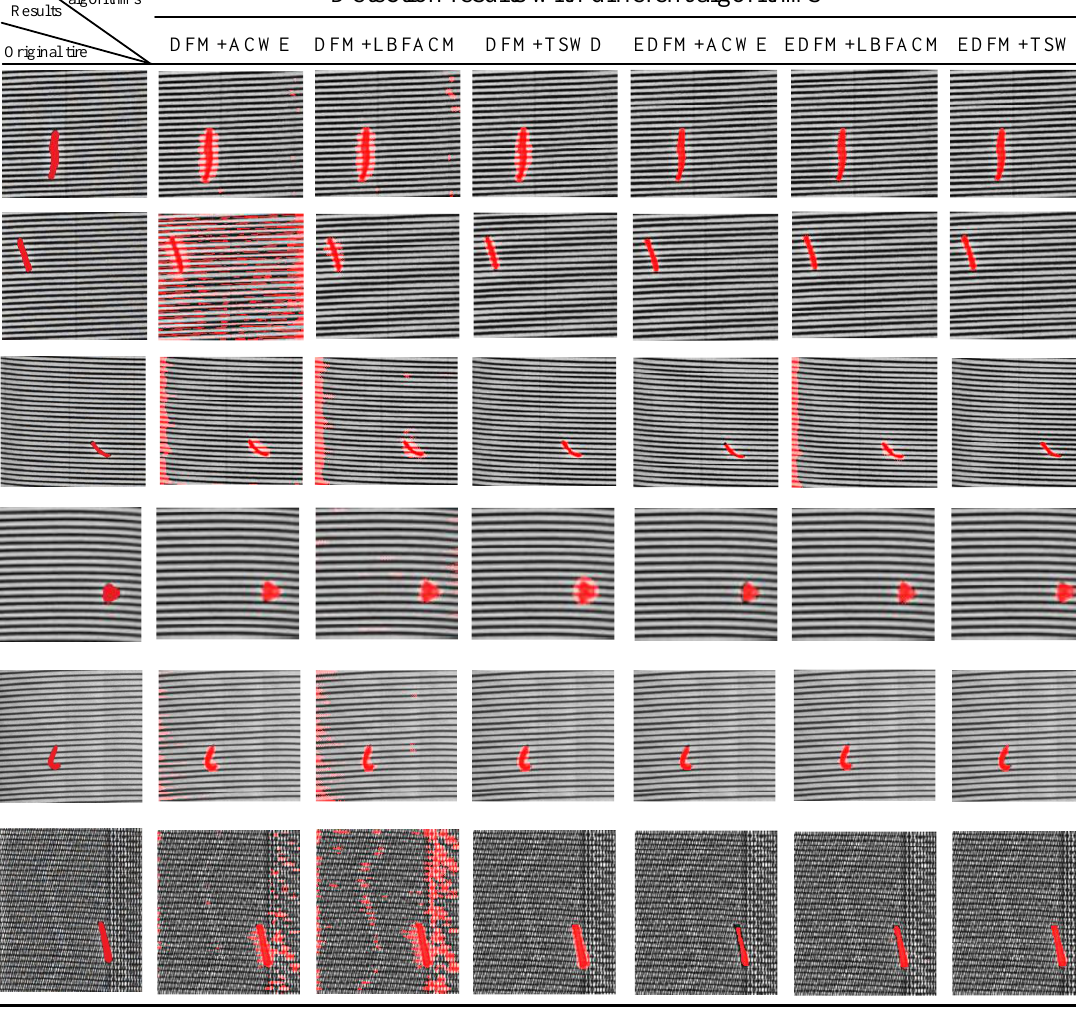
Figure 11. Detection results with different algorithms for tire X-ray images. Table 2. Detection time with different algorithms about typical X-ray